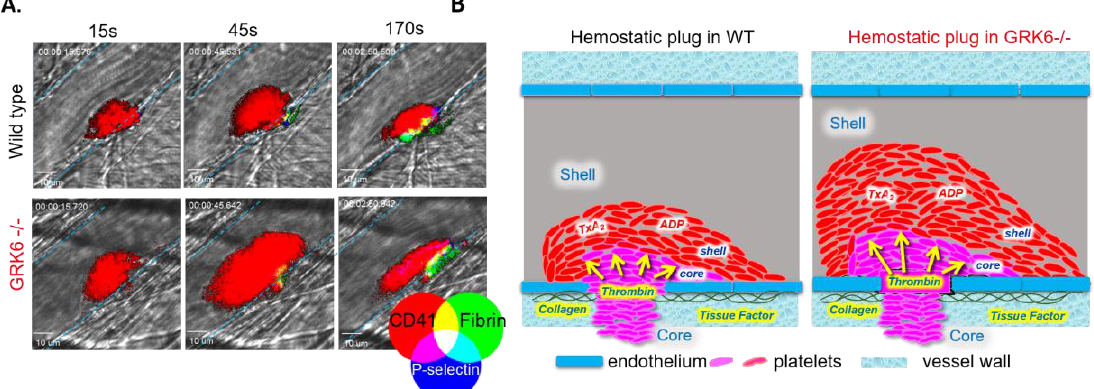
Figure 2. GRK6 regulates the hemostatic response to injury. ( A ) Increased platelet accumulation in GRK6- / - mice following laser injury in a cremaster muscle arteriole as described by Chen et al. [25] Platelets are labeled with fluorescently conjugated anti-CD41 (red), anti-Fibrin (green), and anti-P-selectin (blue). The blue lines mark the vessel walls. The pictures were taken 15, 45, or 170 s after injury. ( B ) The architecture of the hemostatic plug. Left: Hemostatic thrombi formed after penetrating injuries have a characteristic core / shell architecture in which the extent of platelet activation is determined by the distribution and concentration of agonists in the immediate environment of each platelet. The present studies and those discussed in the text show that the thrombus shell is dependent on ADP and TxA 2 , while the core requires thrombin. Right: Knocking out GRK6 causes an increase in PAR4- and P2Y 12 -mediated events, with a rapid increase of platelet accumulation during the early stage of thrombus